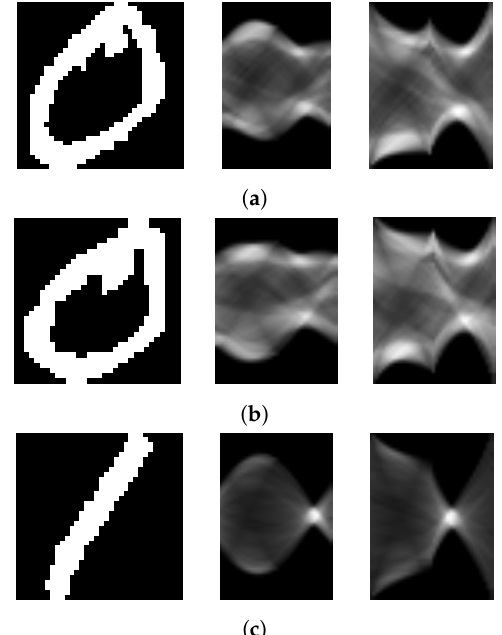
Figure 3. Samples of the Radon and MDIPFL transformations: from left to right the original images, the Radon transformations and the MDIPFL transformations, respectively. Both projection transformations show the projection profiles on range [ 0; π ] . The original images are samples from the NIST [49] dataset. Subfigure ( a , b ) show observations from the same class, subfigure ( c ) is